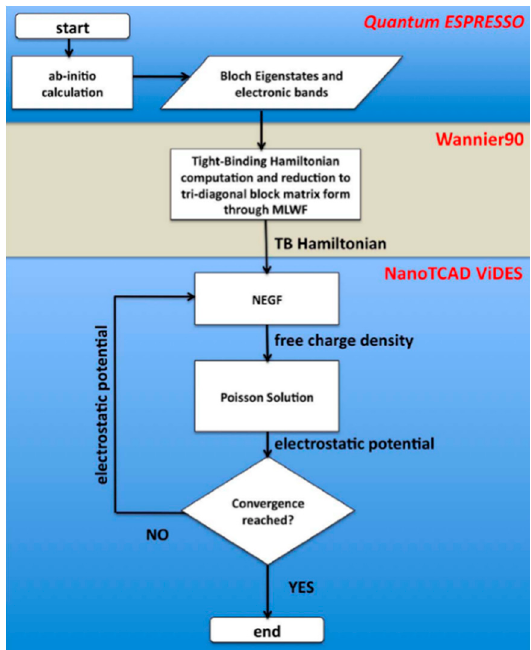
Figure 13. Illustration of the tight-binding (TB)-NEGF self-consistent simulation flow [70]. Nanomaterials 2020 , 10 , x FOR PEER REVIEW